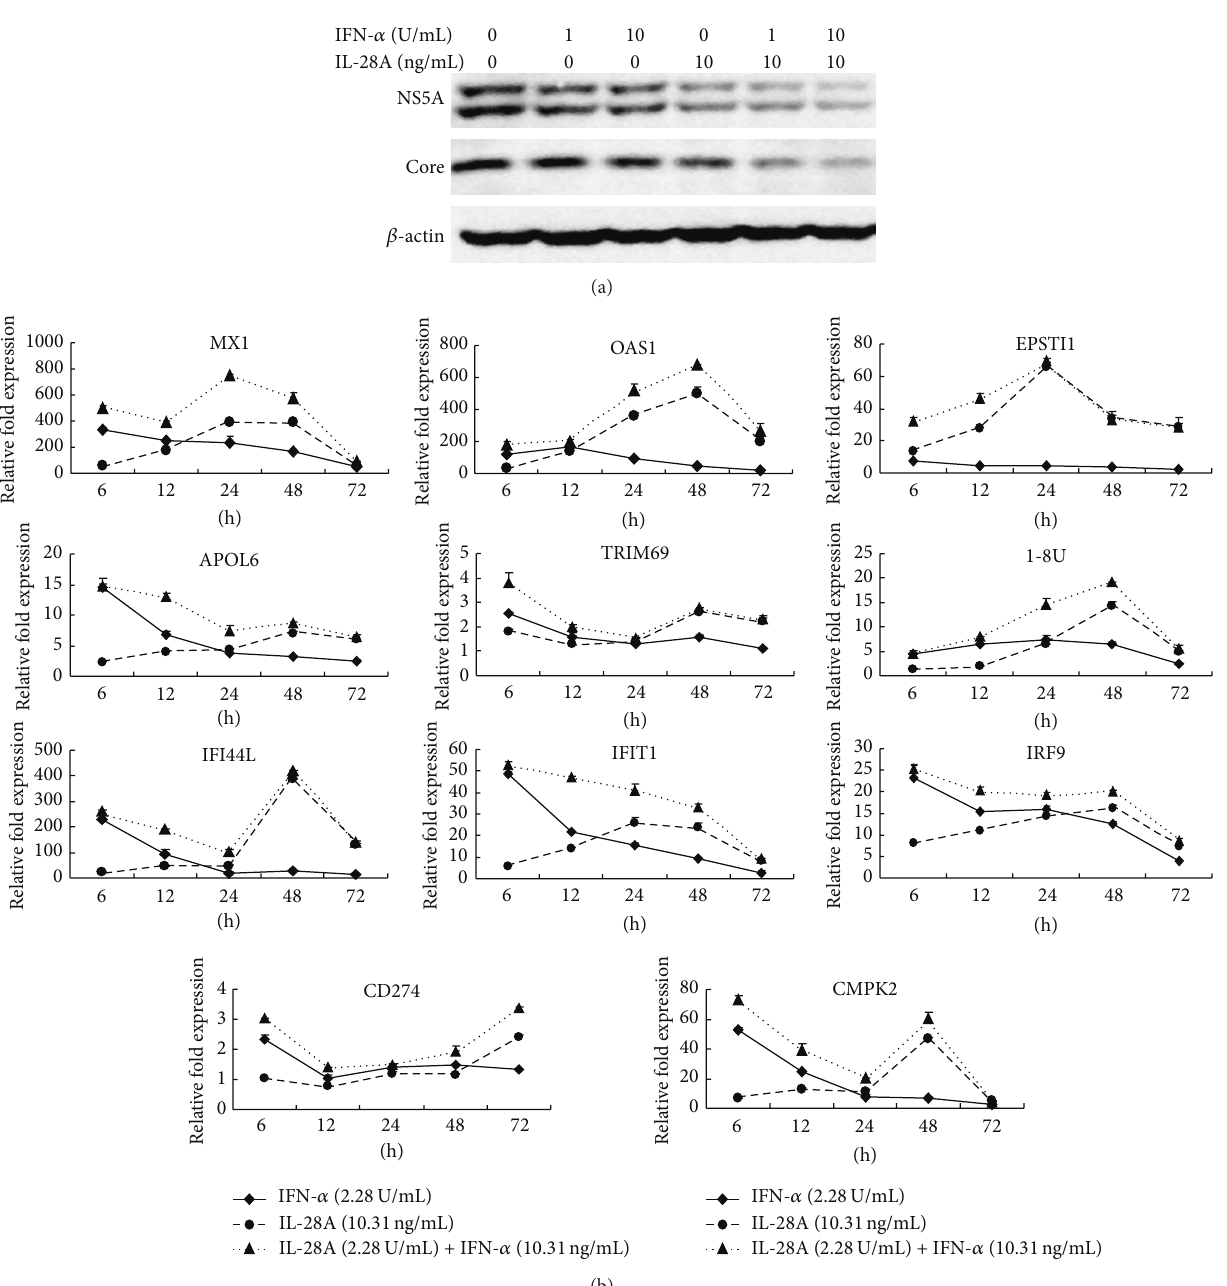
Figure 3: IL-28A and IFN- 𝛼 combination synergistically inhibits HCV replication and induces ISGs expression. (a) Huh7.5 cells were infected with HCV (MOI = 0.1) for 6 h at 37 ∘ C. The medium was then removed and cells were incubated with IL-28A or IFN- 𝛼 or together for 48 h at 37 ∘ C. HCV NS5A and core proteins were detected by western bolt. (b) Huh7.5 cells were treated by IL-28A or/and IFN- 𝛼 for different time courses. The expressions of ISGs, including MX1, OAS1, EPSTI1, APOL6, TRIM69, 1-8U, IFI44L, IFIT1, IRF9, CD274, and CMPK2, were determined by real-time PCR and normalized with